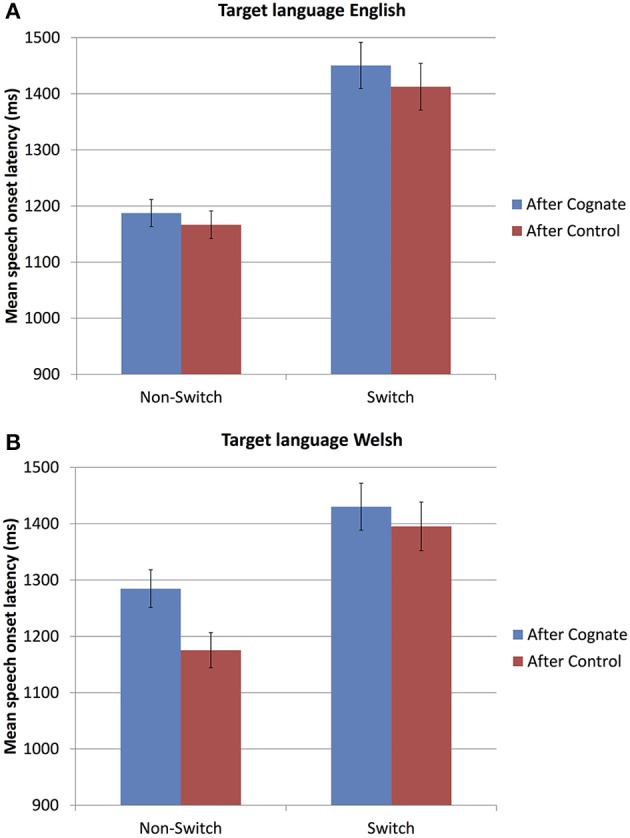
(A,B) Mean naming latencies for non-cognate filler words, in each Target Language (A, English; B, Welsh), for each Cognate condition (i.e., cognate status in the preceding trial), and Language Switching condition. Error bars represent the standard error of the mean across subjects and are for illustrative purposes only.